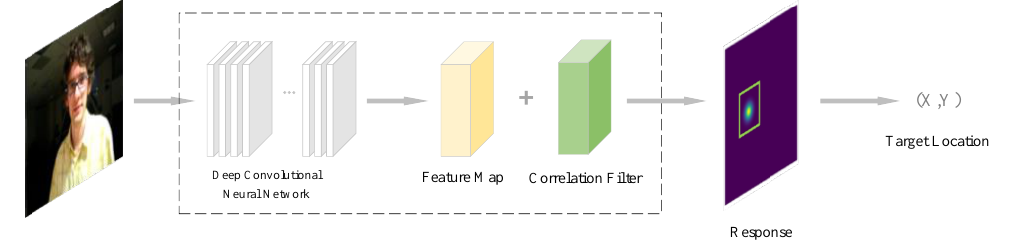
Figure 1. The general process of deep correlation filter tracking model.